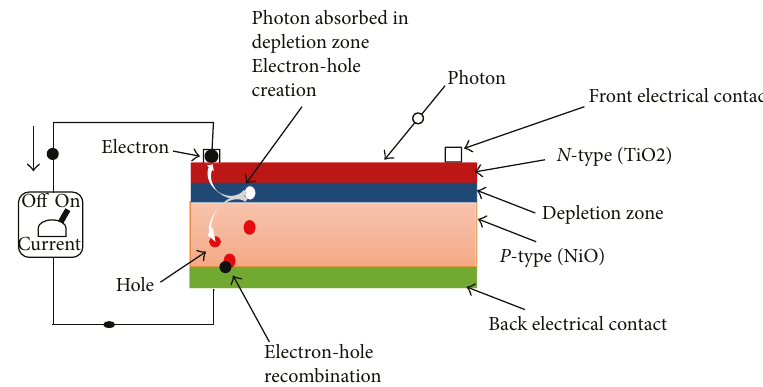
Figure 1: Solar cell generation of electricity using a P - N junction.